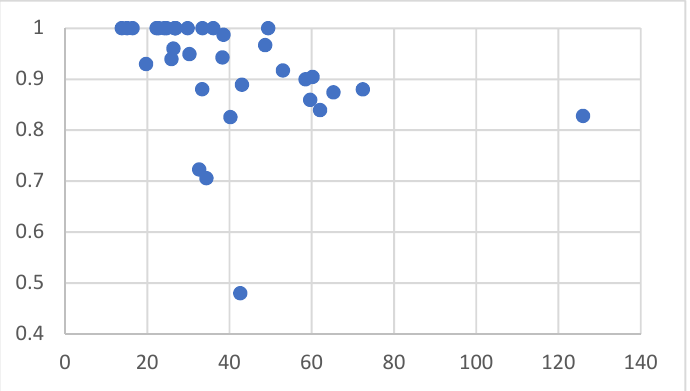
Figure 3. Eco-efficiency level ( y -axis) with respect to land occupation (LO) ( x -axis).